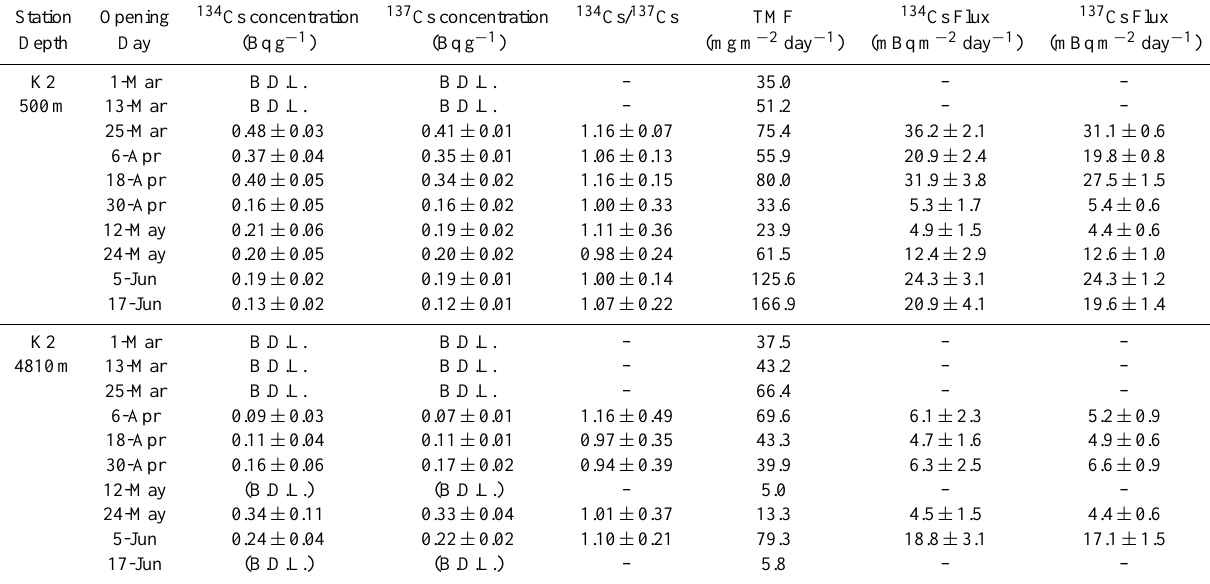
Table 1. Concentrations and fluxes of radiocesium at K2. The analytical error is based on one sigma of counting statistics. Concentrations are decay-corrected based on middle day of each sampling period. B.D.L. is below detection limit (0.01Bq). (B.D.L.) is supposed to be below detection limit because of insufficient sample mass and activity by gamma